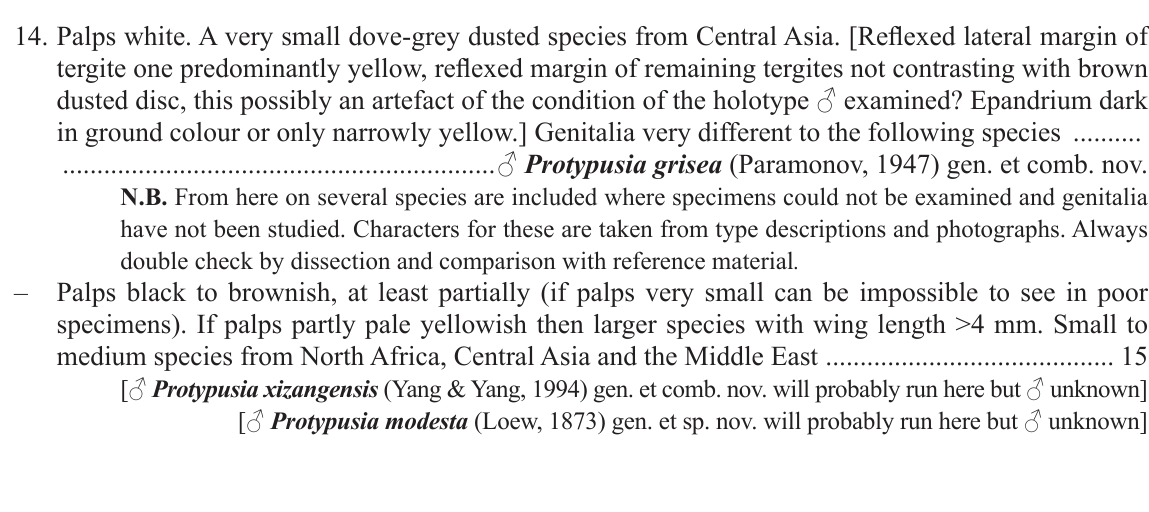
Fig. 12. Protypusia flavipalpis gen. et sp. nov.,